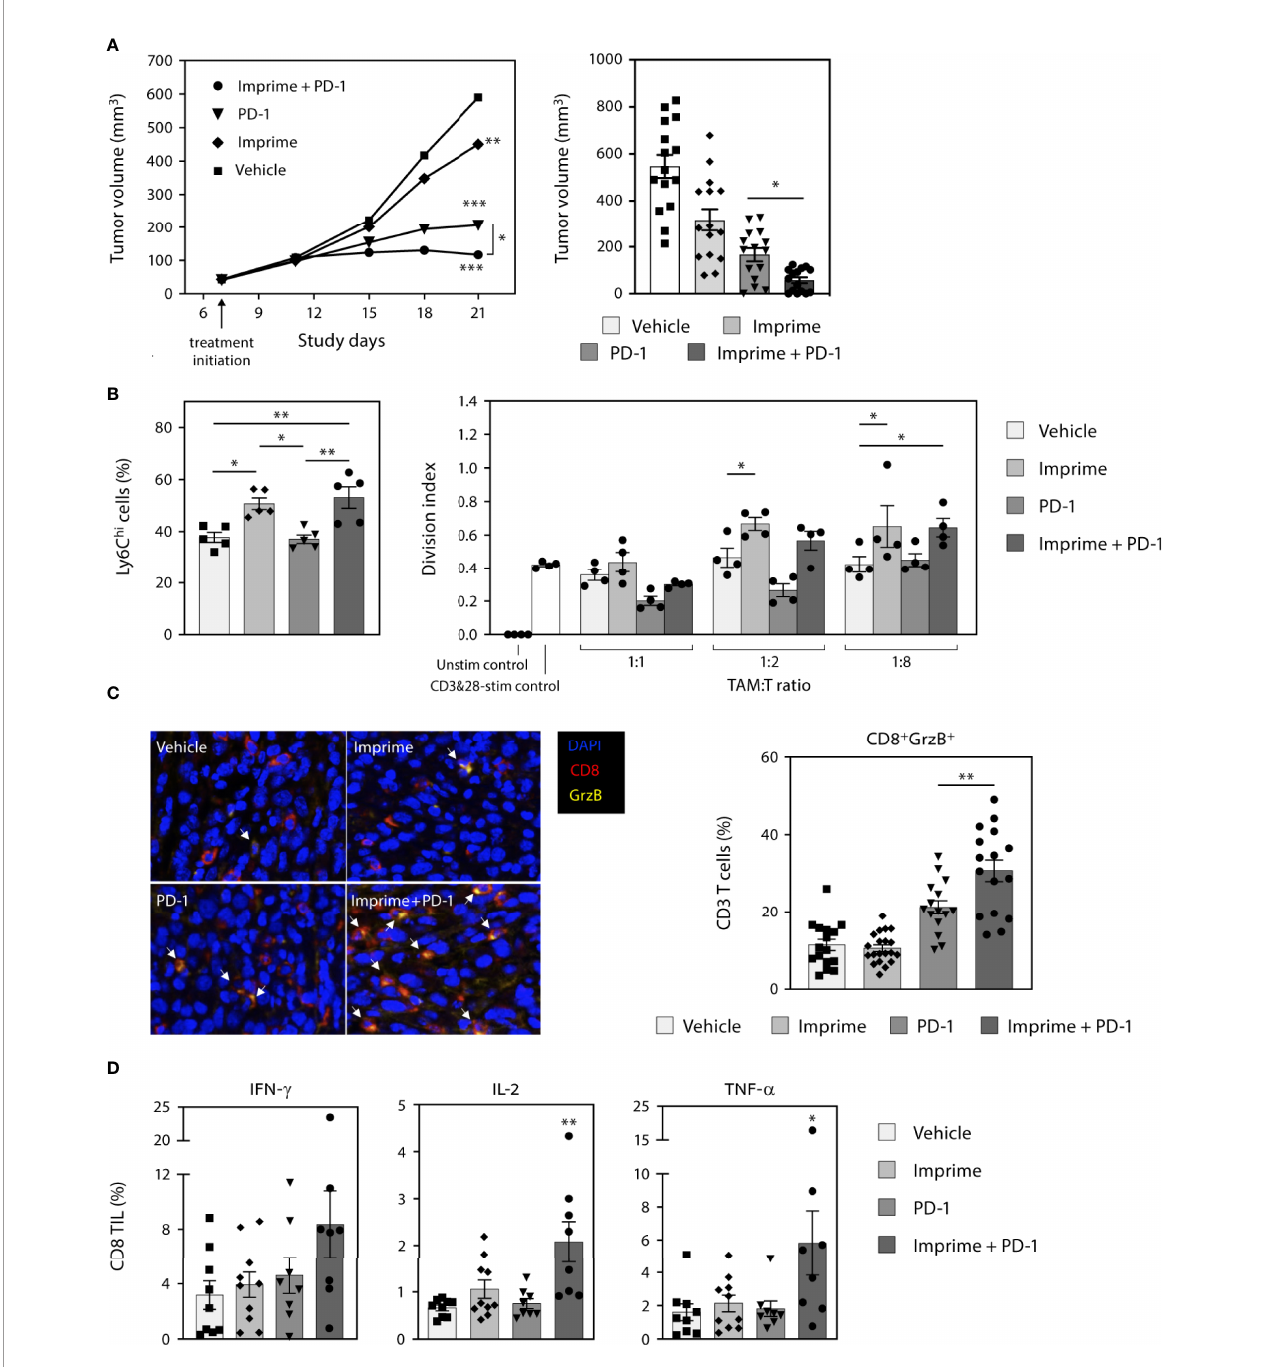
FIGURE 9 | Imprime synergizes with anti-PD-1 Ab therapy in the murine MC38 tumor model. (A) Tumor growth curve in the different treatment groups (n ≥ 10) in the MC38 tumor model is shown on the left. Data is representative of 3 separate experiments. Tumor volume at day 21 are shown in the bar graph on the right. Each symbol in the graph represents an individual mouse. (B) Analysis of the Ly6C hi myeloid population present in the tumor, and functional analysis of TAMs in a T cell suppression assay are shown. (C) Immunohistochemistry data for in fi ltrating activated CD8 T cells are shown as an image and quantitative data presented in the graphical form. Data for each mouse were calculated using 50% coverage of the tumor. (D) Percent CD8 tumor in fi ltrating lymphocytes (TIL) from each treatment group were evaluated for the expression of IFN- g , IL-2, and TNF- a after stimulation with MC38 peptide for 5 hours. For (B-D), representative results from 2 experiments are shown. All summary data are presented as mean ± SEM. Two-way ANOVA using Holm-Sidak for multiple comparison was used in (A-left) , One- way ANOVA using Holm-Sidak for multiple comparison was used in (A-right) , One-way ANOVA using Tukey for multiple comparison was used in (B-left, C, D) , Two-way ANOVA with Dunnett for multiple comparison was used in (B-right) . * p < 0.05, ** p < 0.01, *** p <